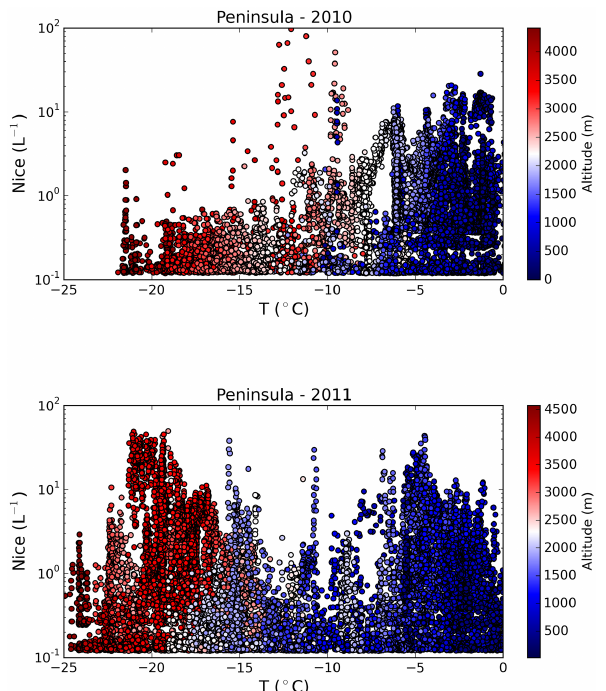
Figure 14. Distribution of all measurements of ice crystals (g − 1 ) as a function of atmospheric temperatures for 2010 (top) and 2011 (bottom) for the whole peninsula. Colour indicates the altitude of the measurement, with light to dark red referring to increasing alti- tudes above ≈ 2500m and colours from light to dark blue referring to altitudes decreasing below ≈